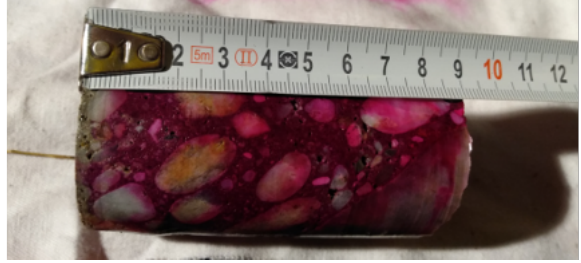
Figure 6. The carbonation depth of concrete at the places with a thin layer of PRC at the surface - sam- ple selected from measurements performed in 2019 (Bridge in Rimavská Sobota).